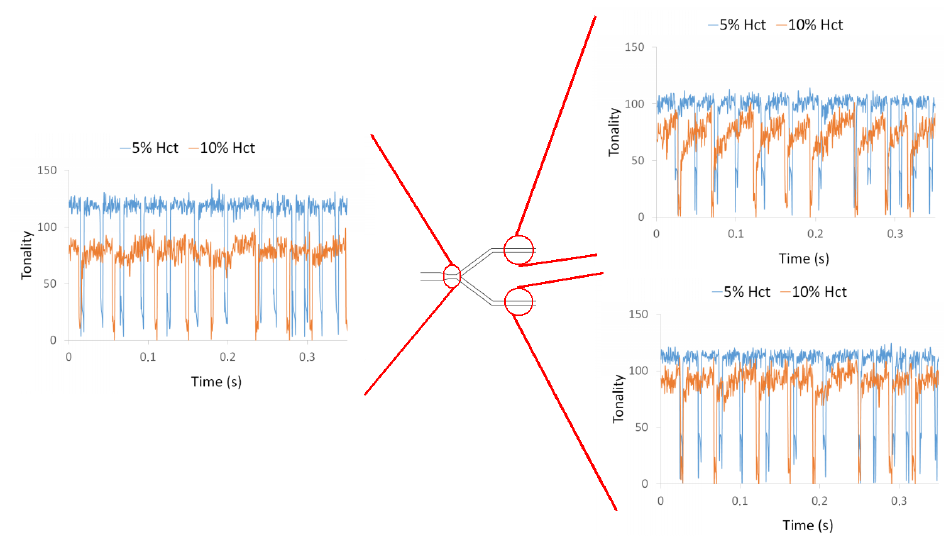
Figure 9. Influence of air bubbles on the local Hct for a flow rate of 10 µL/min for 5% Hct and 10% Hct in bifurcation B2.